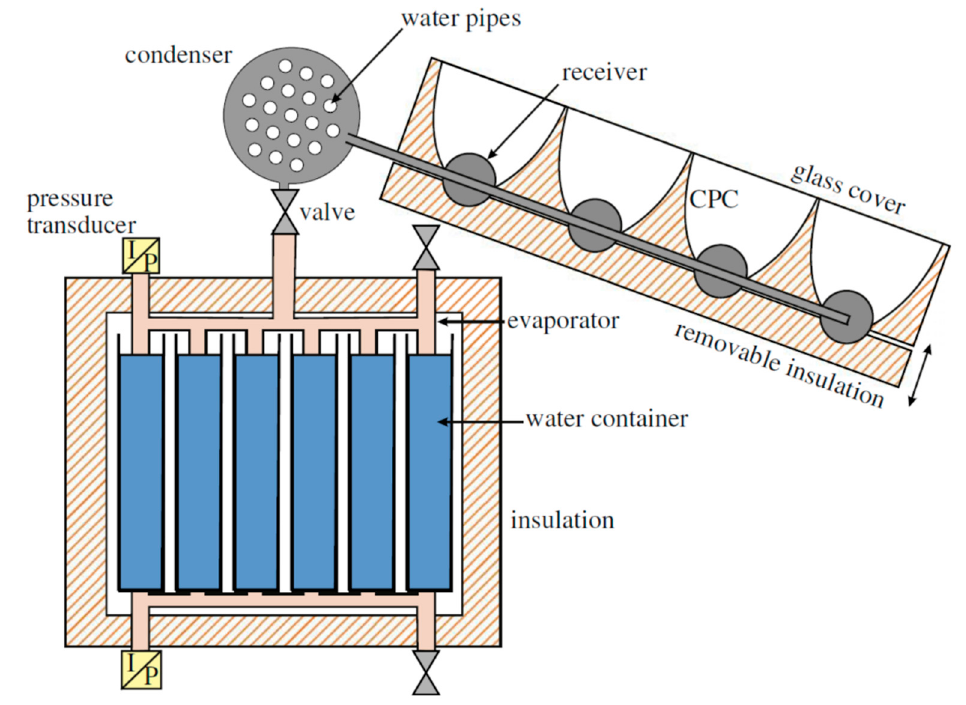
Figure 36. Schematic view of the solid-sorption chiller with CPC [70].